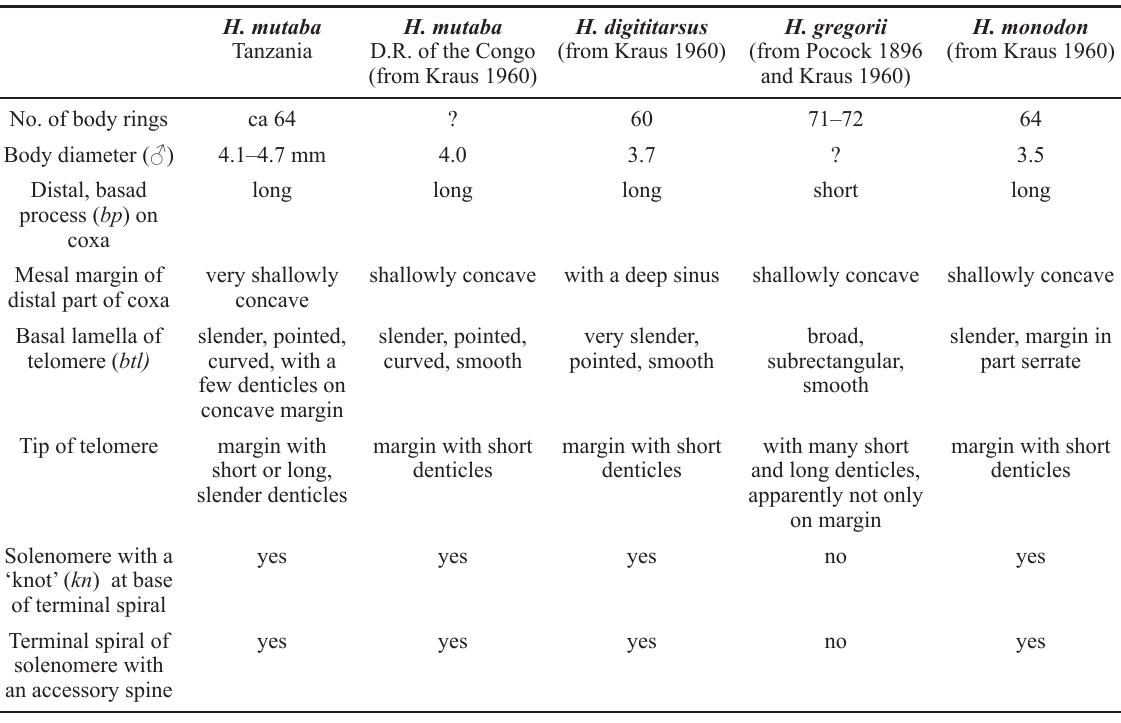
Table 2. Comparison of four species of Helicochetus Attems,